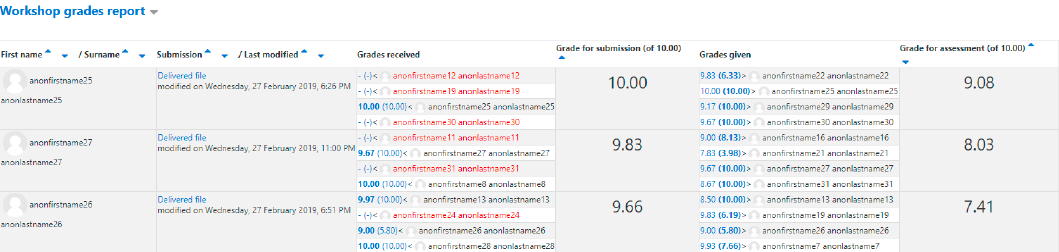
Figure 1. Overview of Moodle Workshop grading table summary.